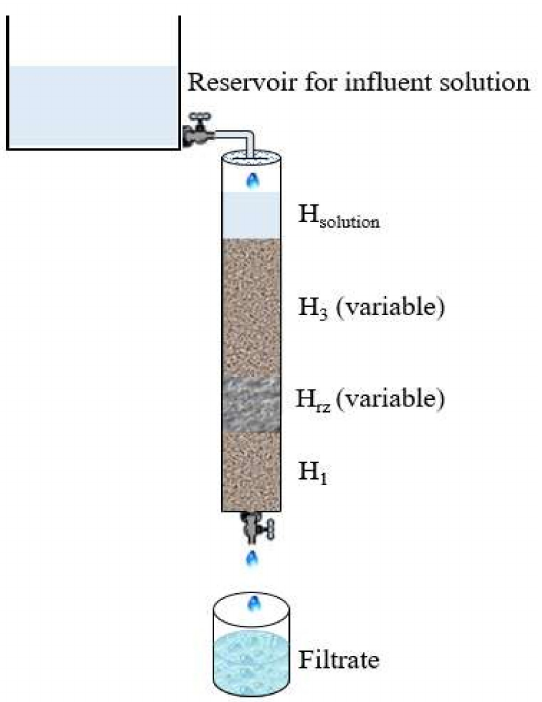
Figure 1. Schematic diagram of experimental setup. Due to the volumetric expansive nature of aqueous iron (Fe 0 ) corrosion, progressive permeability loss during use is expected. A continuous gravity-driven filtration was performed through individual columns for 46